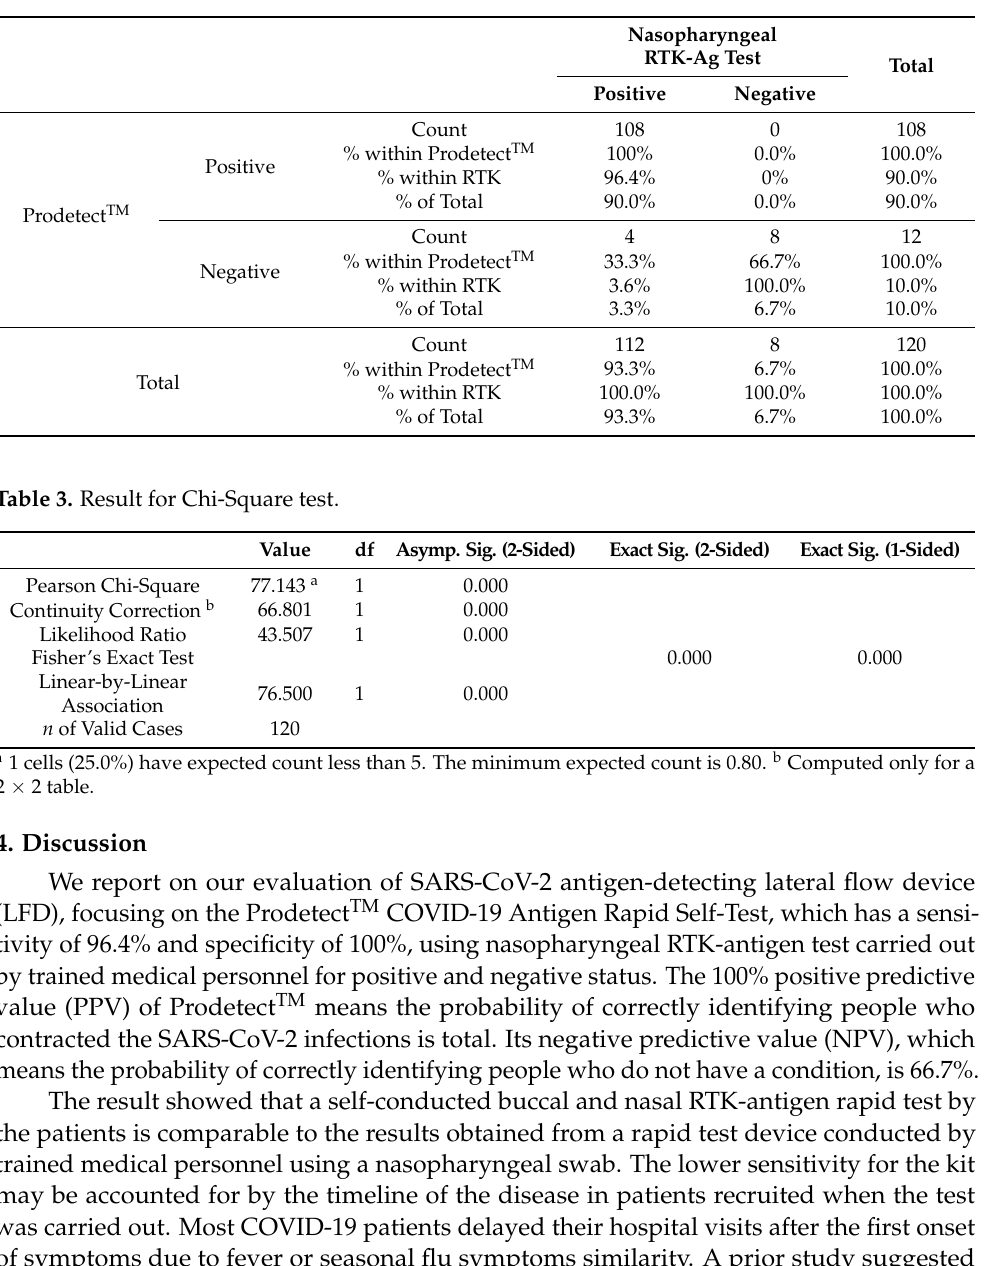
Table 2. Buccal-nasal Prodetect TM Nasopharyngeal RTK-Ag Crosstabulation.